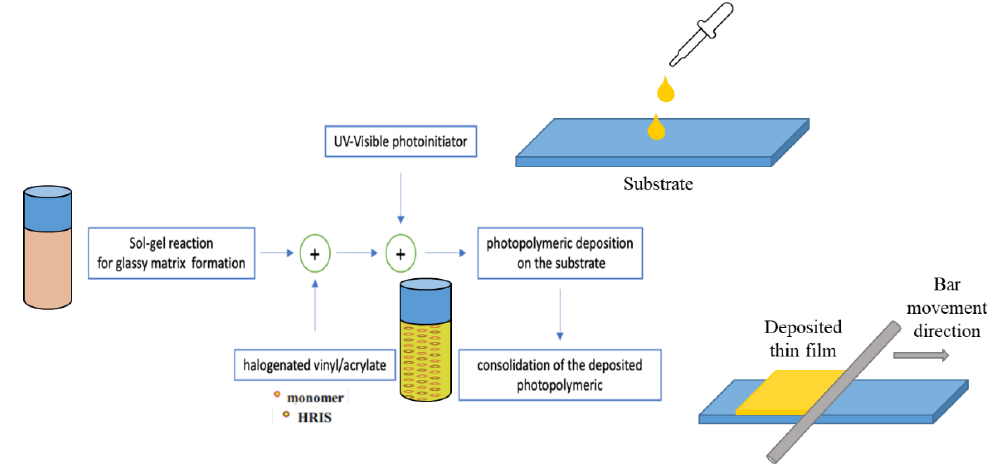
Figure 1. Main technological steps used for the preparation of the sol-gel base photopolymer.